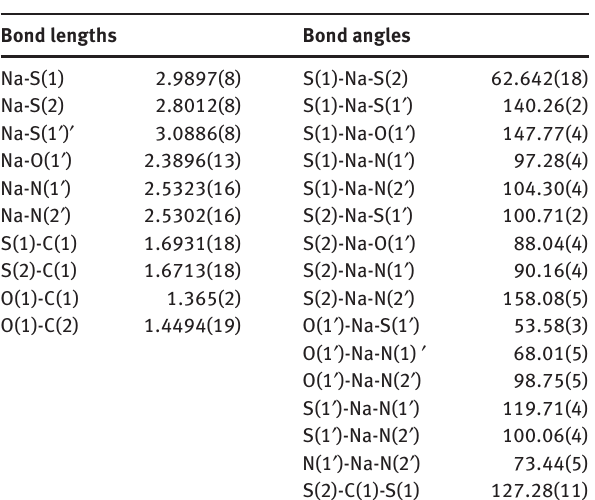
Table 2: Selected bond lengths (Å) and angles ( ° ) for 1 . Bond lengths Bond